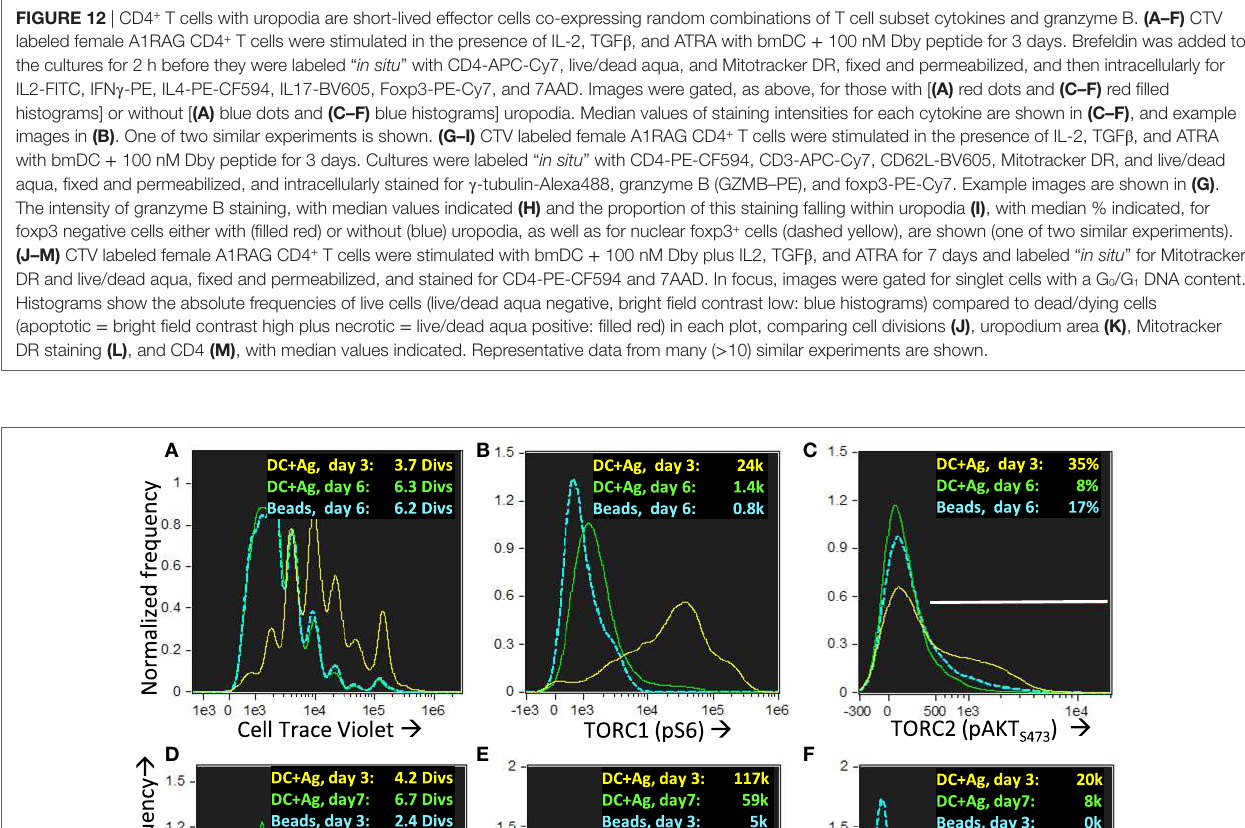
FigUre 12 | CD4 + T cells with uropodia are short-lived effector cells co-expressing random combinations of T cell subset cytokines and granzyme B. (a–F) CTV labeled female A1RAG CD4 + T cells were stimulated in the presence of IL-2, TGF β , and ATRA with bmDC + 100 nM Dby peptide for 3 days. Brefeldin was added to the cultures for 2 h before they were labeled “ in situ ” with CD4-APC-Cy7, live/dead aqua, and Mitotracker DR, fixed and permeabilized, and then intracellularly for IL2-FITC, IFN γ -PE, IL4-PE-CF594, IL17-BV605, Foxp3-PE-Cy7, and 7AAD. Images were gated, as above, for those with [ (a) red dots and (c–F) red filled histograms] or without [ (a) blue dots and (c–F) blue histograms] uropodia. Median values of staining intensities for each cytokine are shown in (c–F) , and example images in (b) . One of two similar experiments is shown. (g–i) CTV labeled female A1RAG CD4 + T cells were stimulated in the presence of IL-2, TGF β , and ATRA with bmDC + 100 nM Dby peptide for 3 days. Cultures were labeled “ in situ ” with CD4-PE-CF594, CD3-APC-Cy7, CD62L-BV605, Mitotracker DR, and live/dead aqua, fixed and permeabilized, and intracellularly stained for γ -tubulin-Alexa488, granzyme B (GZMB–PE), and foxp3-PE-Cy7. Example images are shown in (g) . The intensity of granzyme B staining, with median values indicated (h) and the proportion of this staining falling within uropodia (i) , with median % indicated, for foxp3 negative cells either with (filled red) or without (blue) uropodia, as well as for nuclear foxp3 + cells (dashed yellow), are shown (one of two similar experiments).